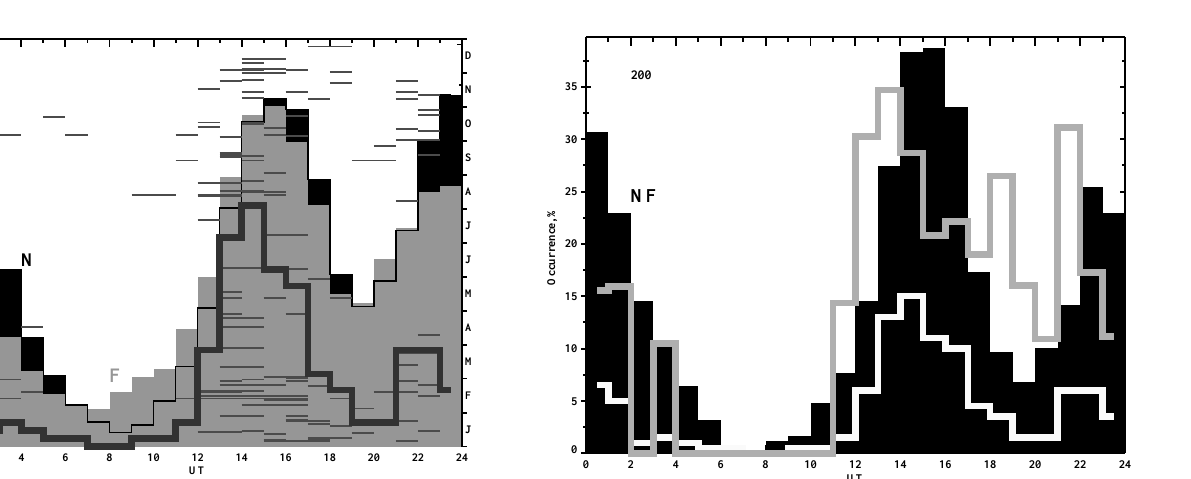
Fig. 4. Diurnal variation of the 1-h periods of STARE observations when both radars detected echoes at least 60% of the time. The white line is the diurnal variation of the total (for each 1-h interval) number of high correlation periods (HCP) (same as in Fig. 3) and the heavy grey line is the relative (with respect to the STARE 60%- occurrence) HCP occurrence normalized to